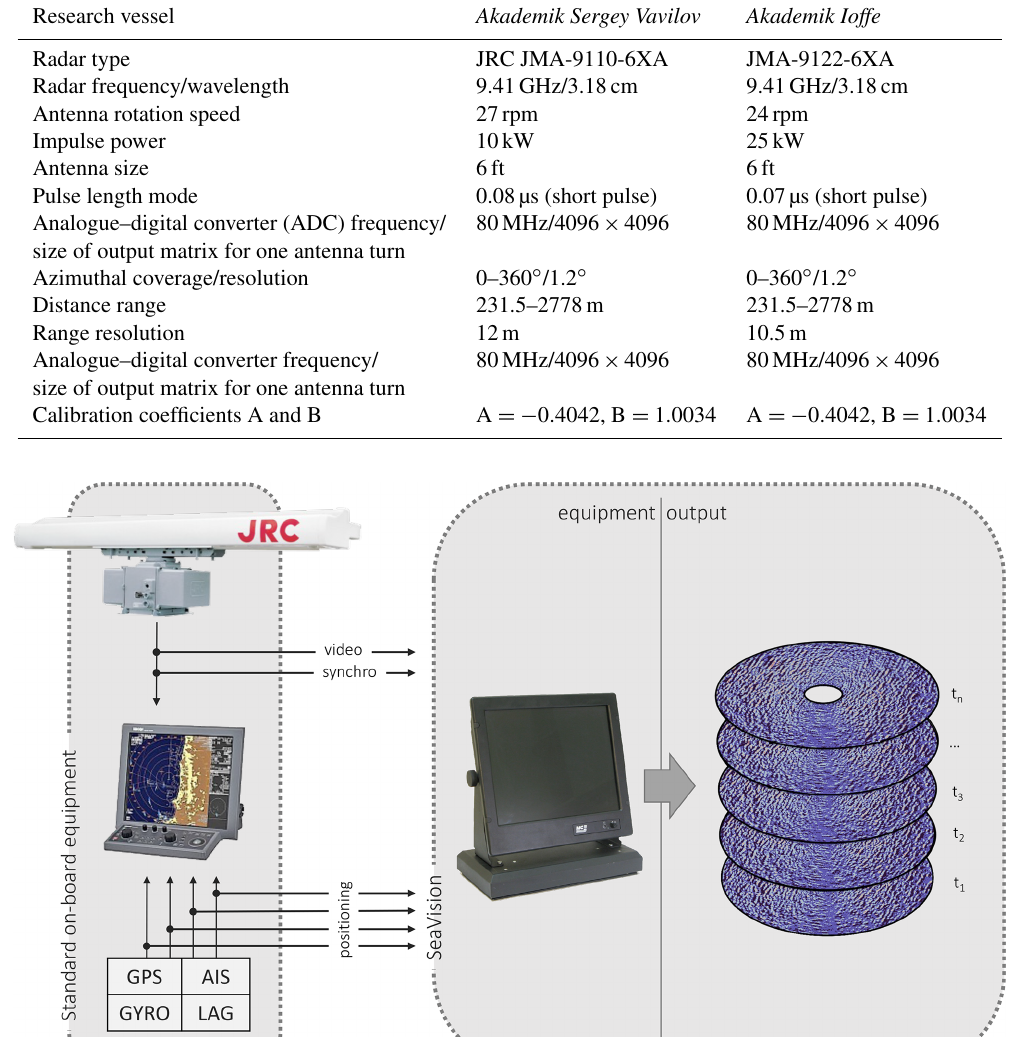
Table 2. JRC JMA-9110-6XA radar (R/V ASV ) and JMA-9122-6XA (R/V AI ) transmission and reception characteristics.